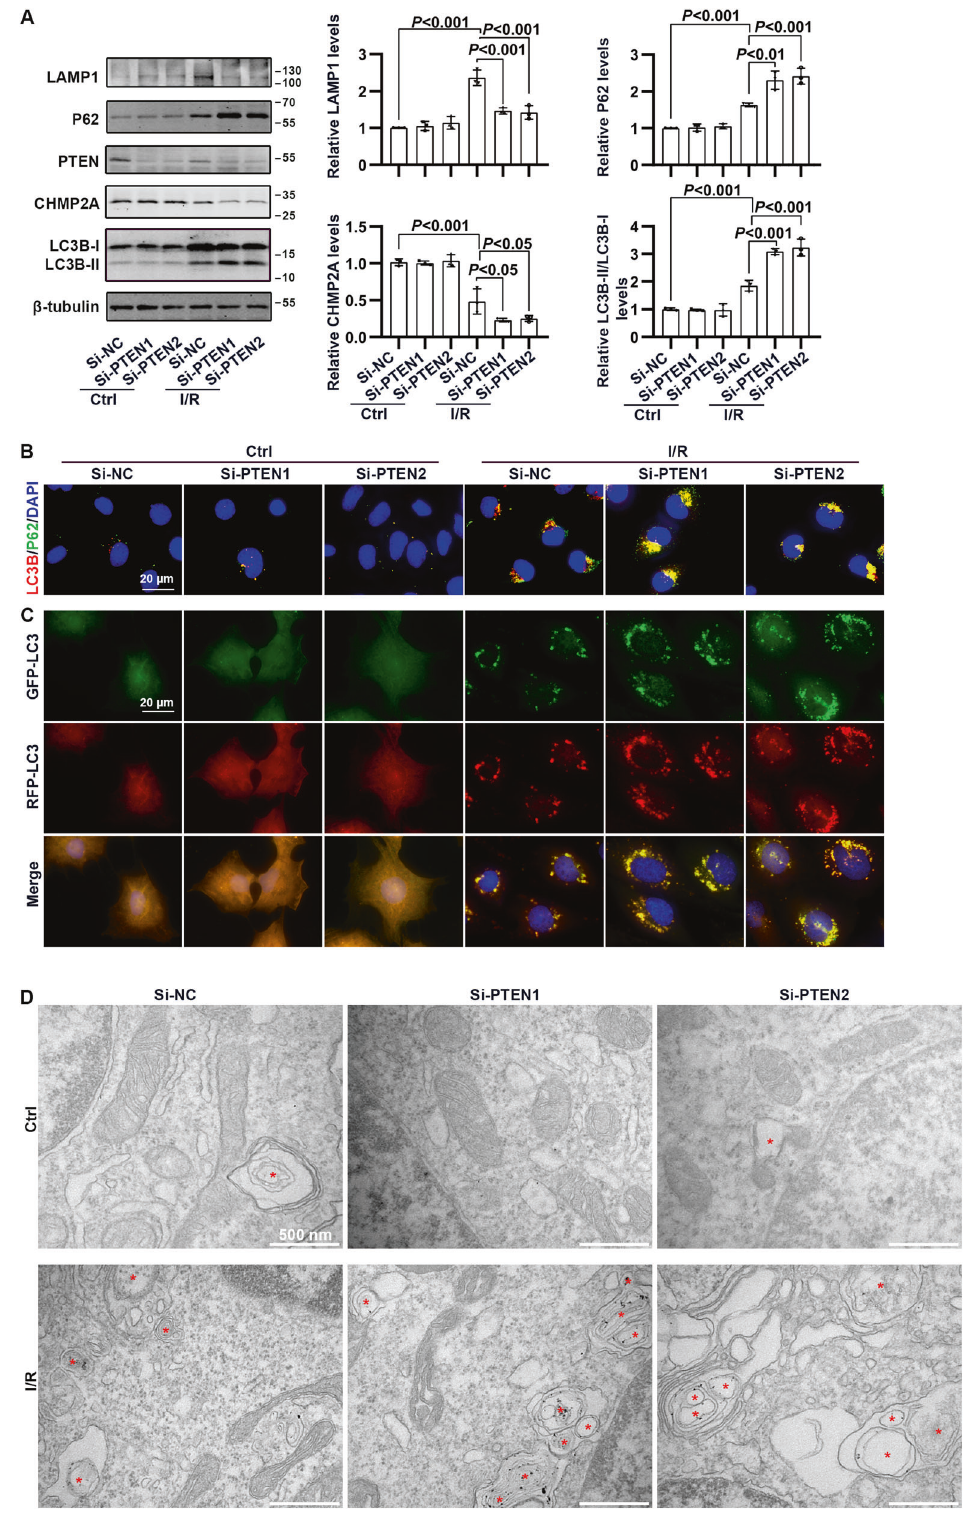
Fig. 6 The in fl uence of PTEN de fi ciency on CHMP2A-mediated autophagy fl ux in HK-2 cells subjected to I/R. A Western blotting analysis showing changes in CHMP2A and autophagy fl ux-related proteins in I/R-treated HK-2 cells in the absence and presence of si-PTEN. B Representative dual fl uorescence of LC3 and P62 staining in I/R-treated HK-2 cells in the absence and presence of si-PTEN (scale bar, 20 μ m). C Representative immuno fl uorescence images of RFP-GFP-LC3 in I/R-treated HK-2 cells in the absence and presence of si-PTEN, which allowed differentiation between autophagosomes (RFP + GFP + , yellow puncta) and autolysosomes (RFP + GFP − , red puncta; scale bar, 20 μ m). D Representative transmission electron microscopic images of autophagic structures in I/R-treated HK-2 cells in the absence and presence of si-PTEN (scale bar, 500